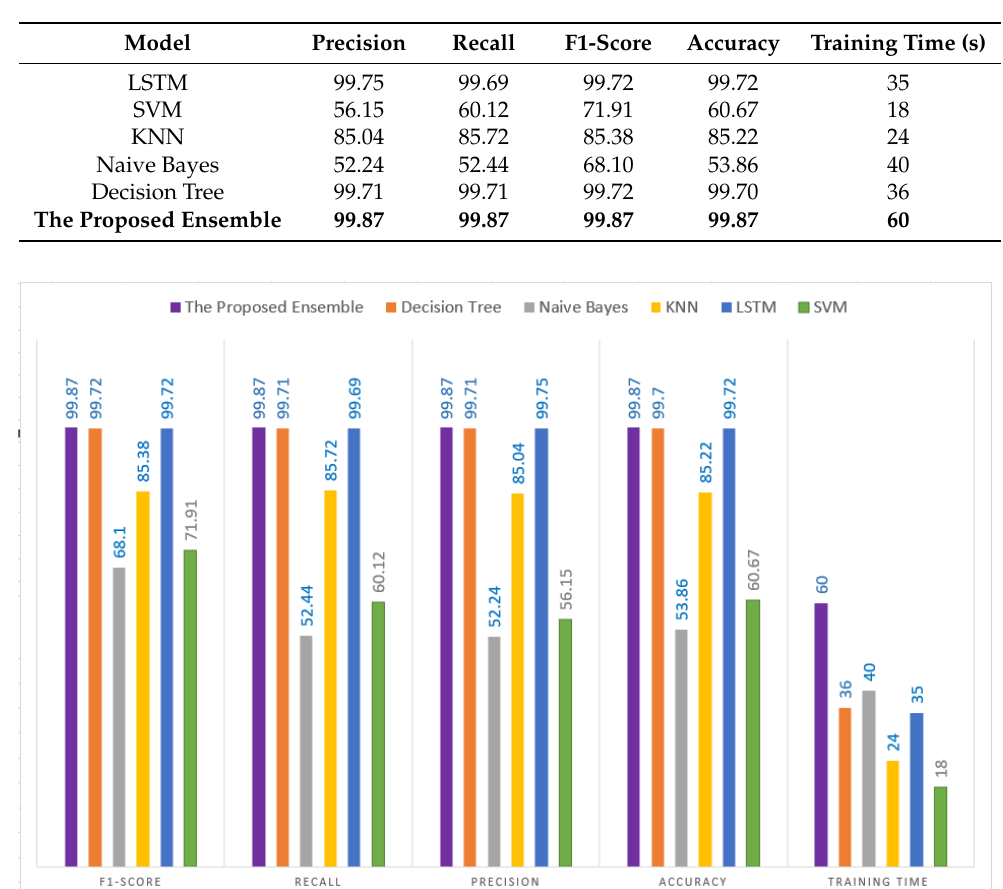
Figure 7. The performance evaluation of the Snapchat classification model. Table 3. Results of Models Classification.